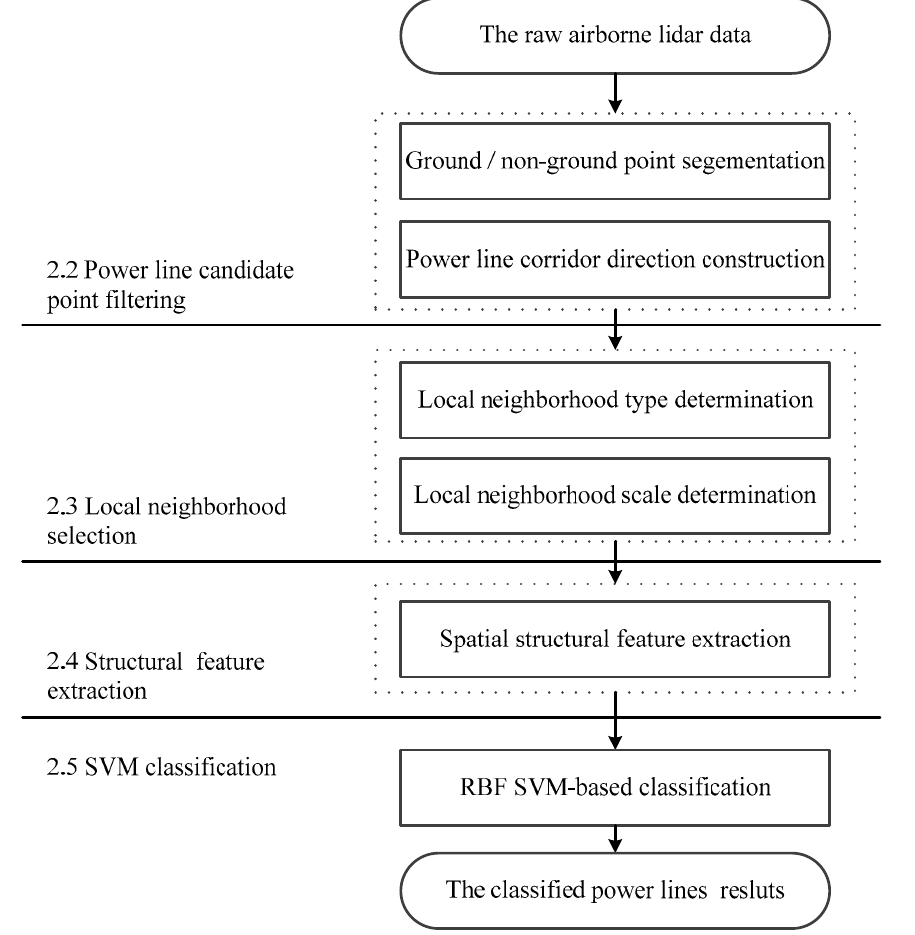
Figure 1. The whole process framework of our methodology.